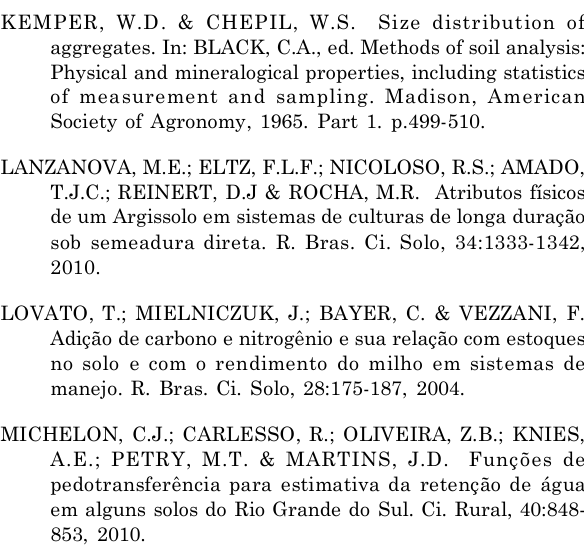
Figura 2. Diâmetro médio ponderado (DMP) para as profundidades de 0-5 (a) e 5-10 cm (b) do solo. Amostragem feita 30 dias após o manejo do consórcio (roçada e deposição da biomassa sobre o solo) para cada sistema de cultivo: milho + feijão-caupi (M + FC); milho em monocultivo (Mon); milho + guandu anão (M + GA) e milho + mucuna-preta (M + MP). Associada a cada coleta nos sistemas de cultivo, foi amostrada a área em pousio. Letras minúsculas diferentes nas barras indicam diferença entre o pousio e o cultivo correspondente, pelo teste de Tukey a 5